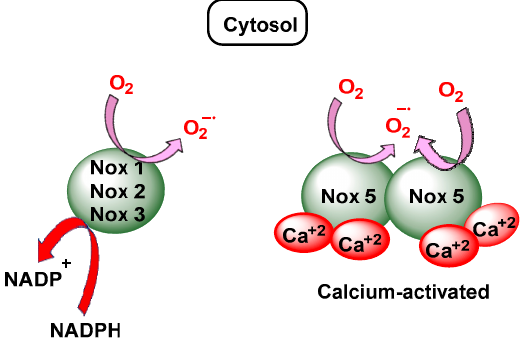
Figure 13. The NOX family of O 2•– generating NADPH oxidases.